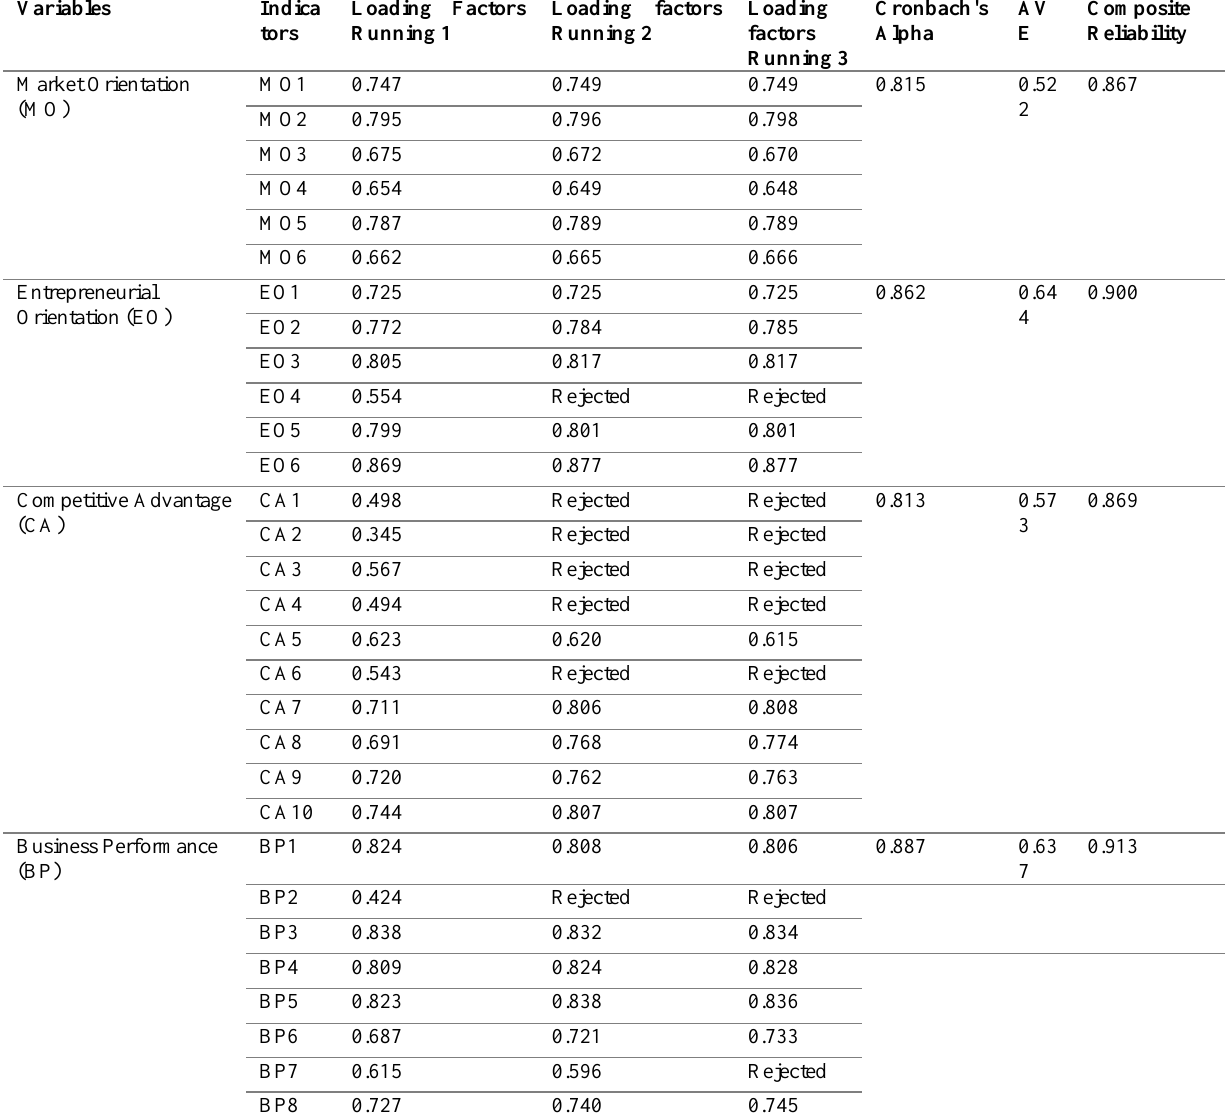
Table 1: Variables, Indicators, Loading Factor, AVEs and Composite Reliability